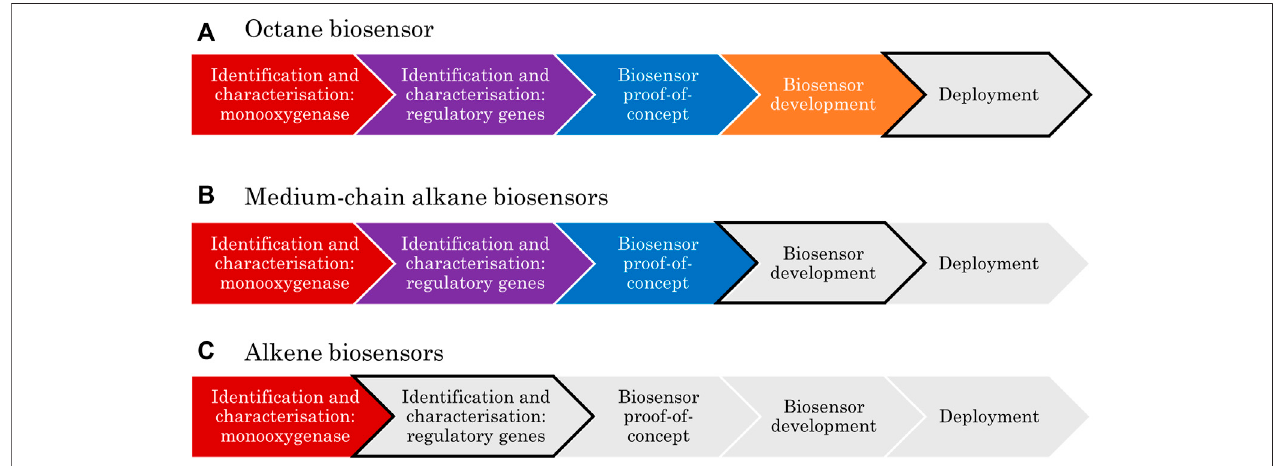
FIGURE 5 | Status of development of octane (A) , medium-chain alkane (B) , and alkene biosensors (C) , with priority research areas yielding maximum impacts indicated by the dark outlined arrows.